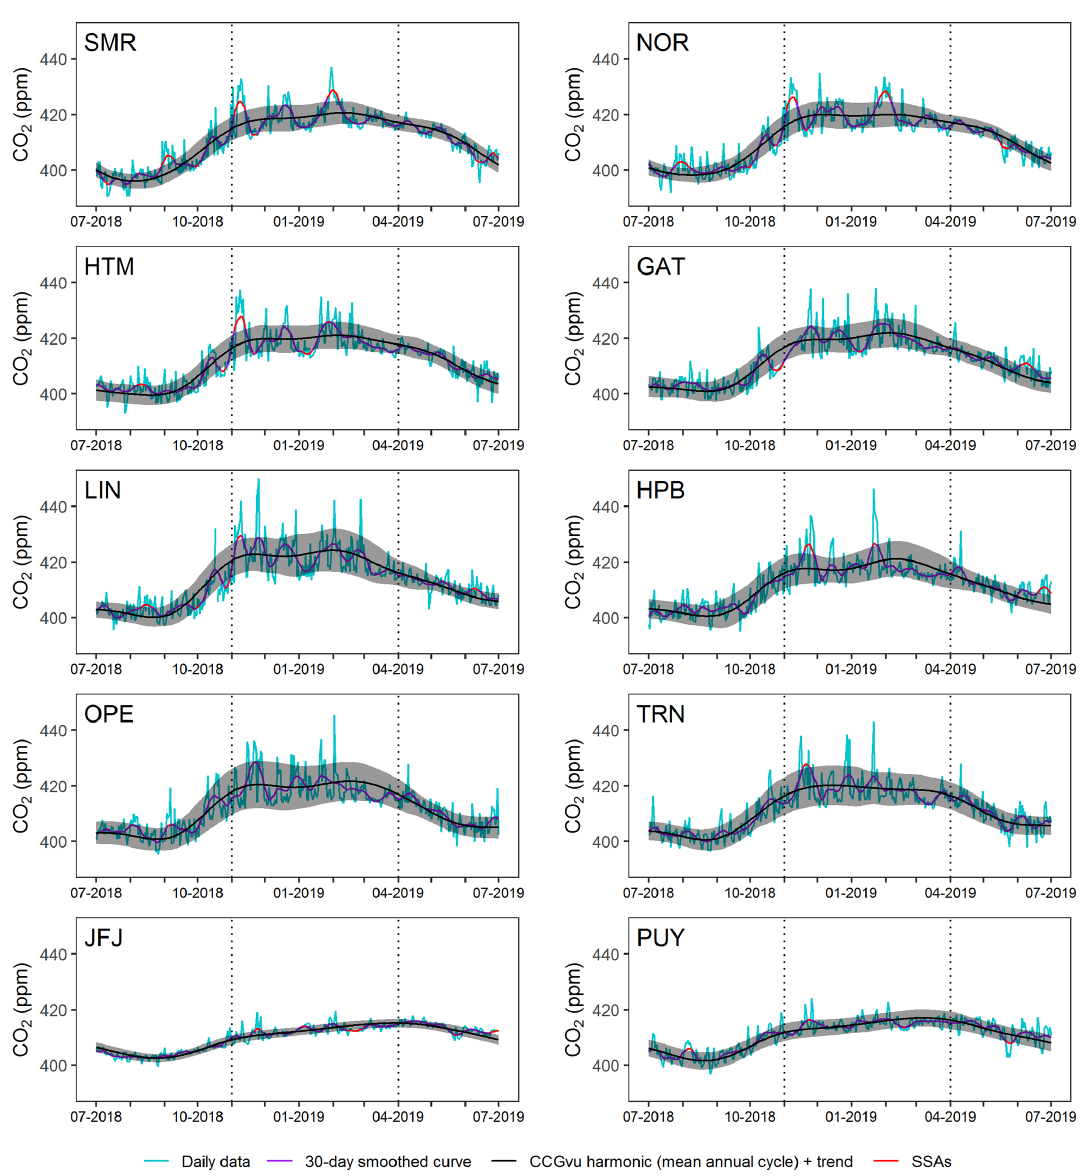
Figure 4. Daily aggregated CO 2 readings for 1 July 2018–1 July 2019 (blue). The background signal derived using the CCGCRV harmonic + trend curve is shown in black. The gray envelope represents the ± 2 σ range of the 30d smoothed cycle about the background signal, and the purple curve is a 30d smoothing of the daily data. SSAs are highlighted in red. Dashed lines show the extended winter